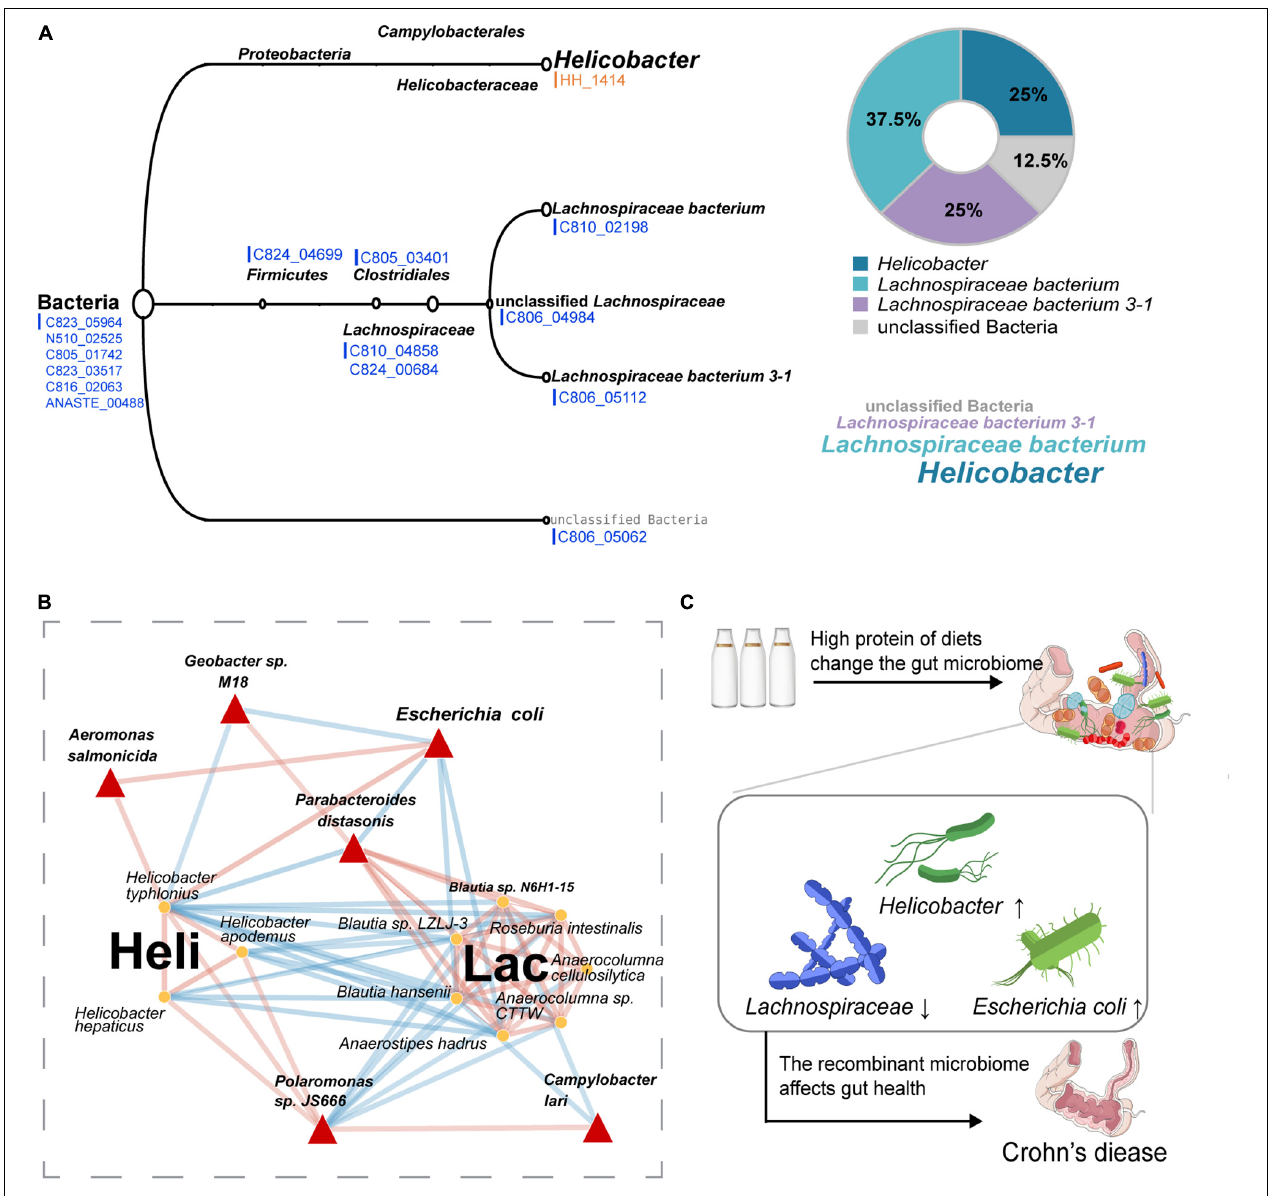
FIGURE 4 | Sources of differential OGs and the symbiotic relationship of these microbes under HPD. (A) The classification levels of 15 different OGs are shown, orange represents those enriched in HPD group, and blue represents the enrichment in SD group. (B) A sub-network containing Helicobacter genus, Lachnospiraceae family, and the filtered six hub species is extracted from the previous microbial co-occurrence network. Red links indicate positive covariation between two individual nodes, whereas blue links indicate negative covariation. The hub species are marked by red triangles. In addition, “Heli” represents Helicobacter , and “Lac” represents Lachnospiraceae . (C) A hypothetical pattern that HPD affects Crohn’s disease by altering the composition of gut microbes is